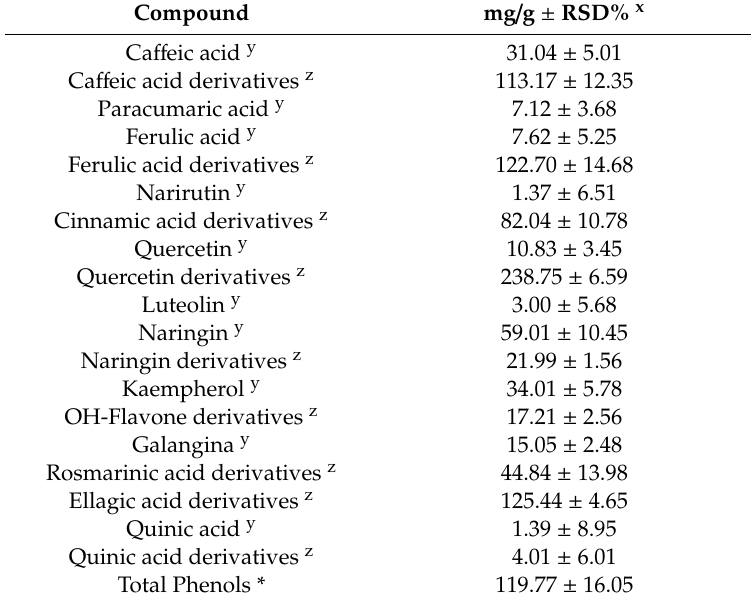
Table 1. Total phenols (spectrophotometric) and main phenolic compounds (HPLC-DAD) in the propolis used in the